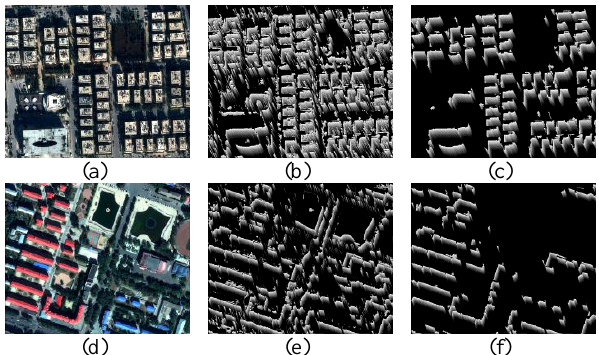
Figure 2. (a, d) Geoeye-1 pan-sharped images (RGB). The fuzzy landscapes generated using the shadow masks provided in Fig. 1c, f are illustrated in (b, e), respectively. The fuzzy landscapes after applying the pruning step are shown in (c,